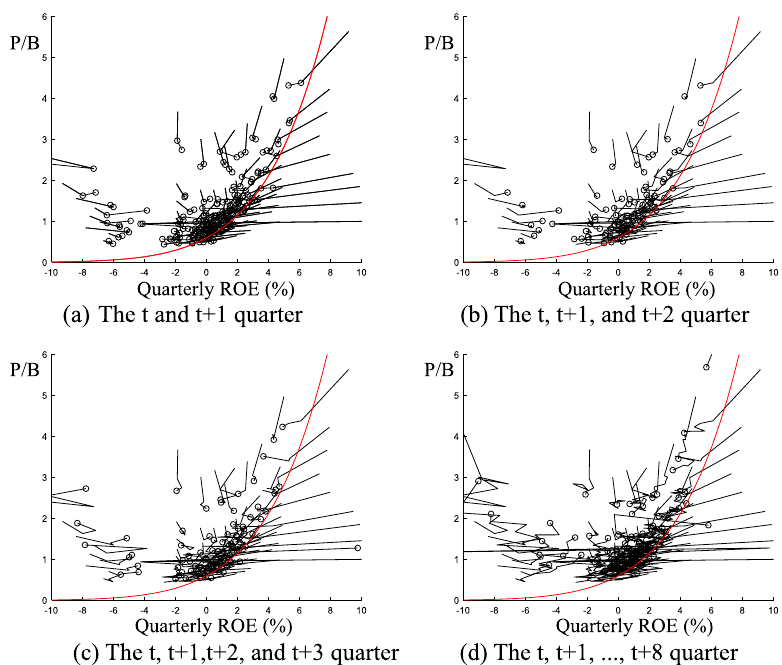
Fig. 19 The movement path of ROE (X axis) and P/B (Y axis) in the current quarter and the subsequent 1, 2, 3, and 8 quarters: Small momentum